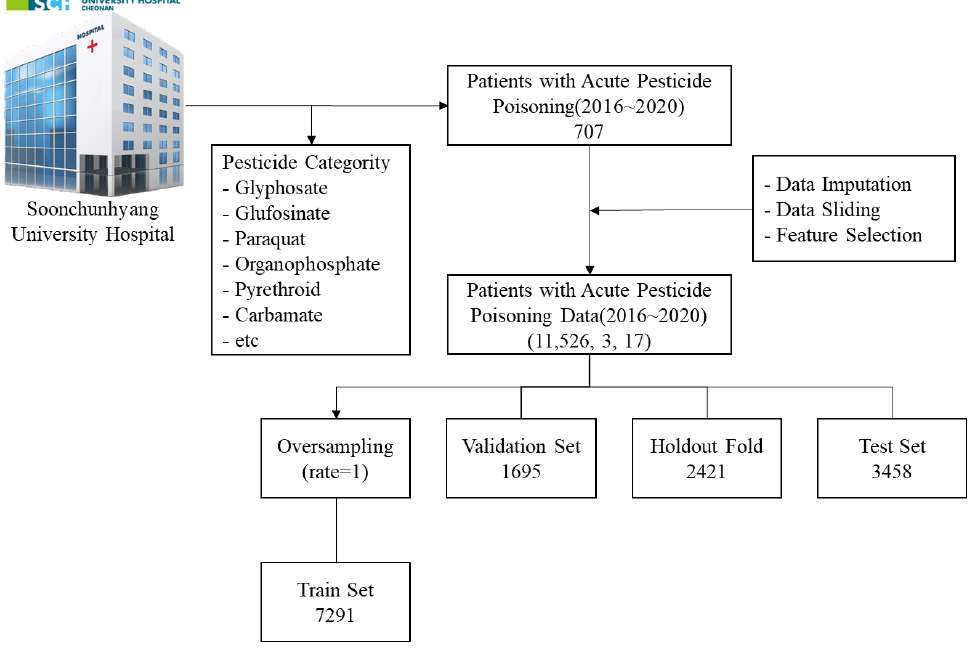
Figure 1. Patient selection, data preprocessing, and dataset. The training dataset number was 7291, and the validation set number was 1695, and the holdout fold number was 2421, and the test dataset number was 3458.